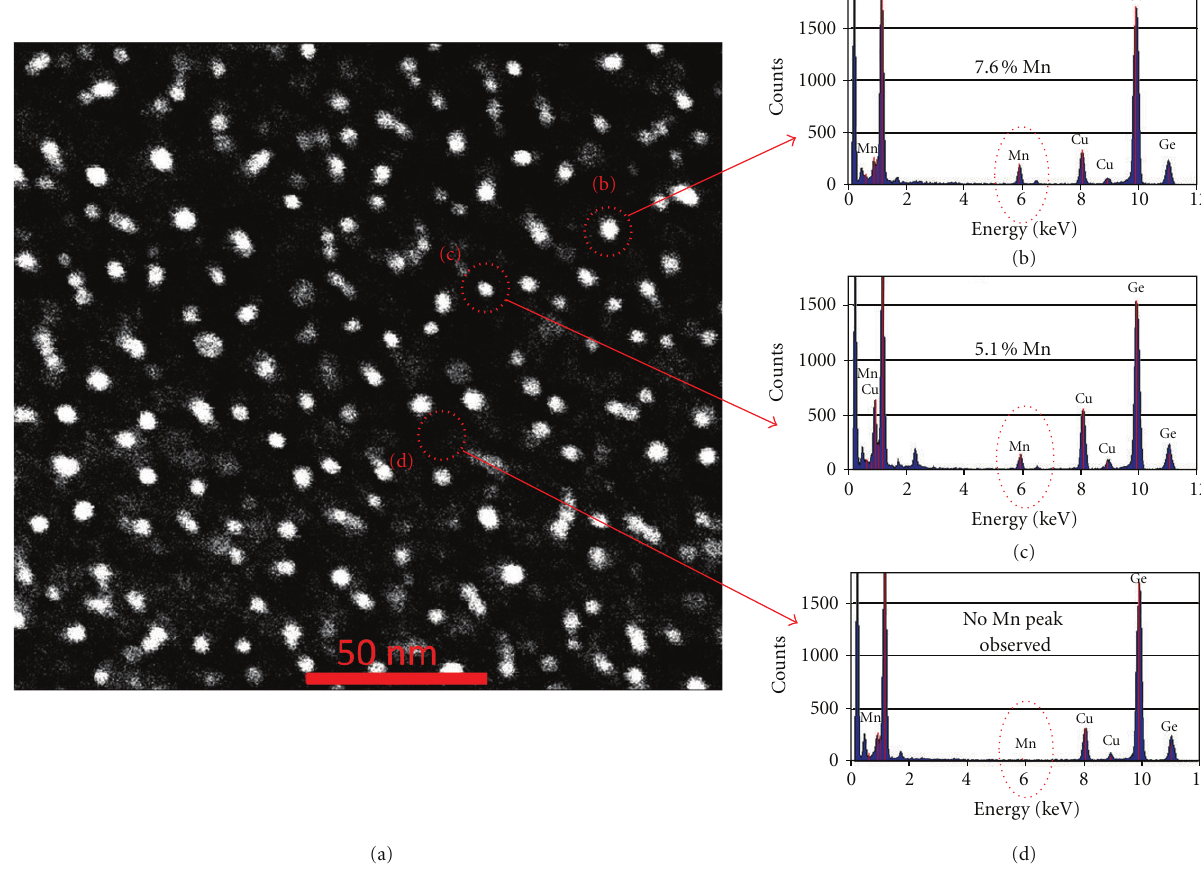
Figure 16: (a) A plane-view dark-field STEM image showing the MnGe nanodots (white spots). ((b)–(d)) EDS profiles showing Mn and Ge peaks and the Mn concentration in the regions marked in (a).